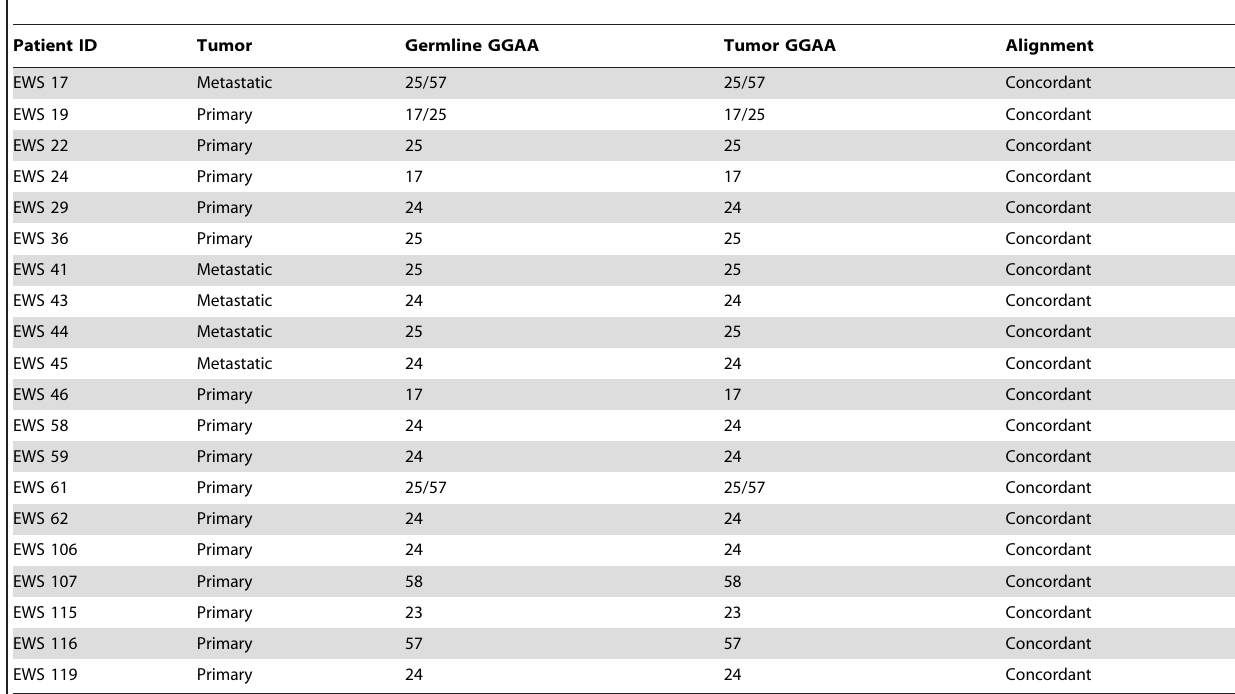
Table 3. Comparison of germline and tumor NR0B1 GGAA-microsatellites.